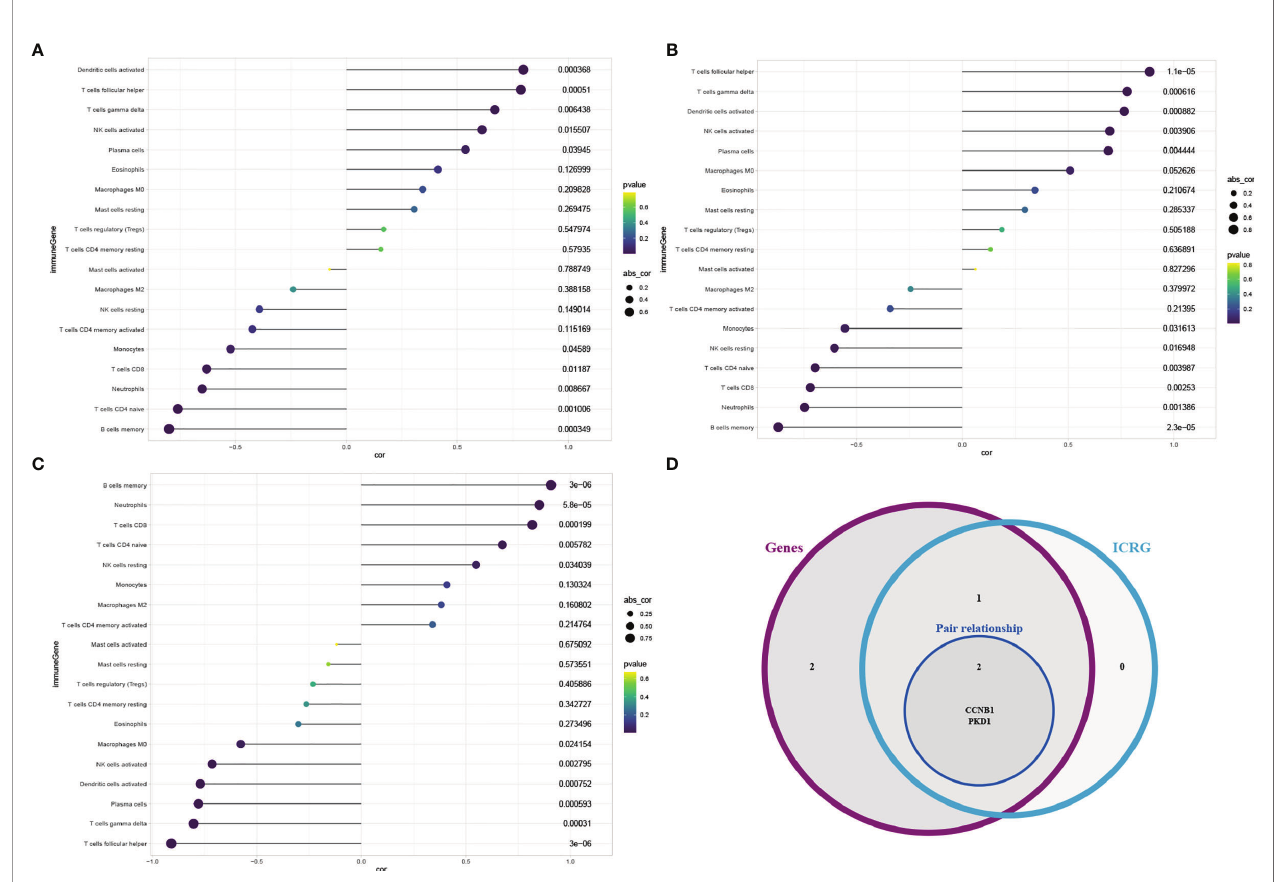
FIGURE 5 | Correlation analysis between in fi ltrating immune cell subtypes with the candidate De-OSRGs. Spearman correlation analysis between immune cell subtypes and CCNB1 (A) / PKD1 (B) / COX15 (C) . Venn diagram (D) showing the key gene pair shared by the immune cell-related genes (ICRG) and candidate